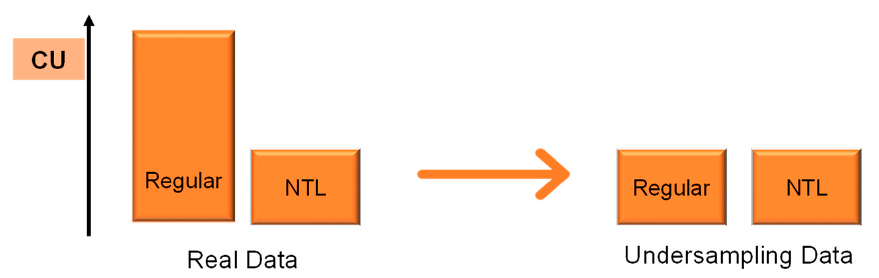
Figure 4. Undersampling—Training database.